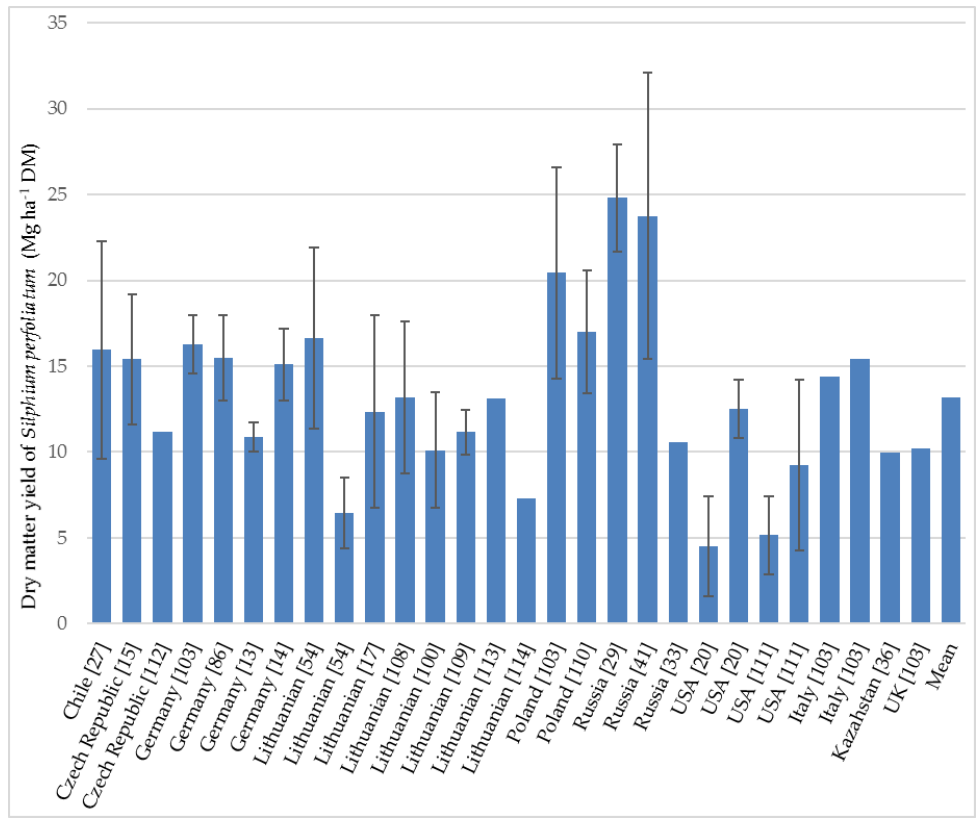
Figure 3. Dry matter yield of Silphium perfoliatum in different countries influenced by different factors (fertilizers, growing areas and different years of growth) and the mean for all countries; error bars represent the minimum and maximum values.